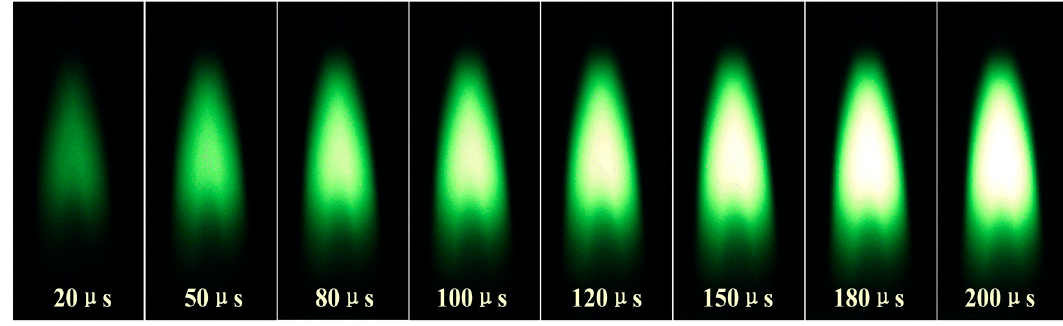
Figure 5. Original flame images.